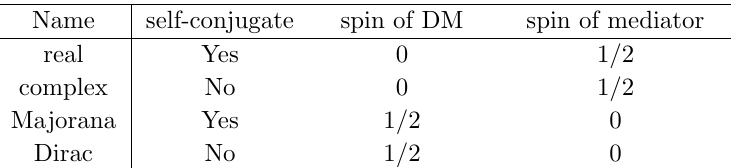
Table 1 . Classi(cid:12)cation of DM models based on spins of DMs and